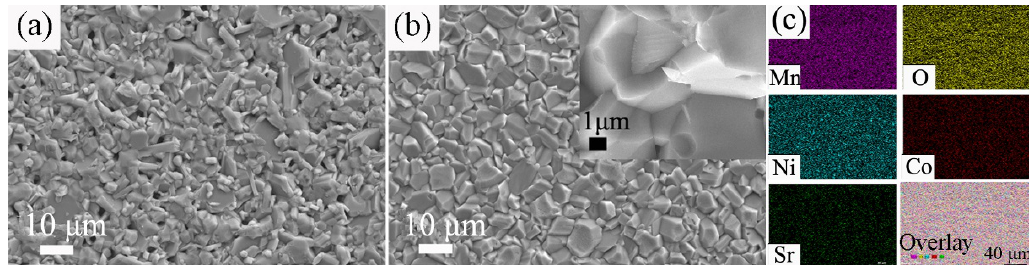
Fig. 6 SEM images of the A2 ceramic after sintering at (a) 1150 and (b) 1175 ℃ (the inset shows the corresponding cross-sectional SEM image). (c) EDS maps of different elements.